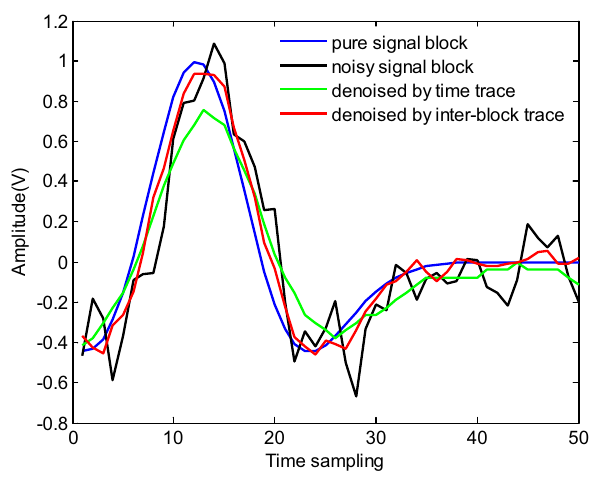
Fig. 6 Result of two filtering methods for block